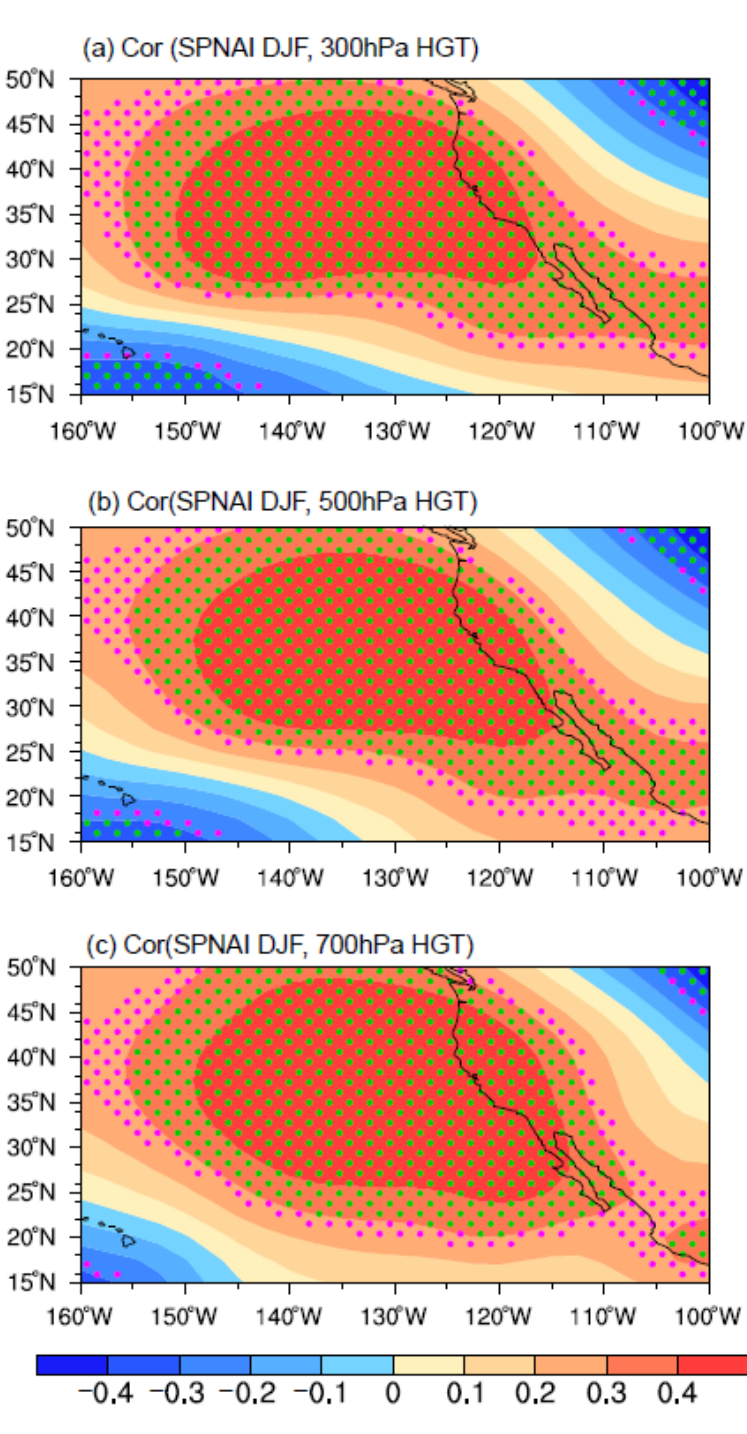
Figure 9. Partial correlation maps between the winter SPNAI and winter local geopotential height (HGT) at ( a ) 300 hPa, ( b ) 500 hPa, and ( c ) 700 hPa without the ENSO signal. The magenta and green stippled areas indicate statistical significance at the 90% and 95% confidence levels, respectively.